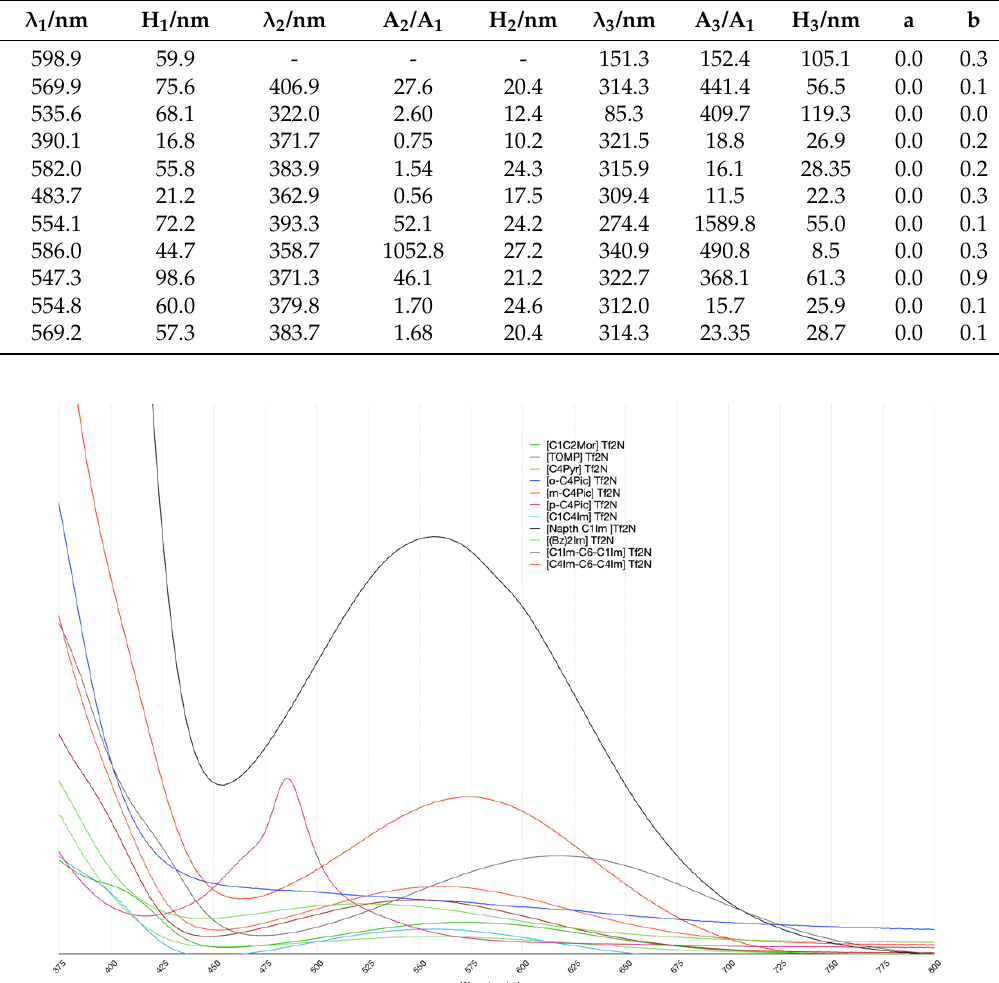
Table 3. Deconvolution fitting of UV-VIS spectra. H is the half-width at half-height. The areas A were normalized with respect to the area of transition 1.